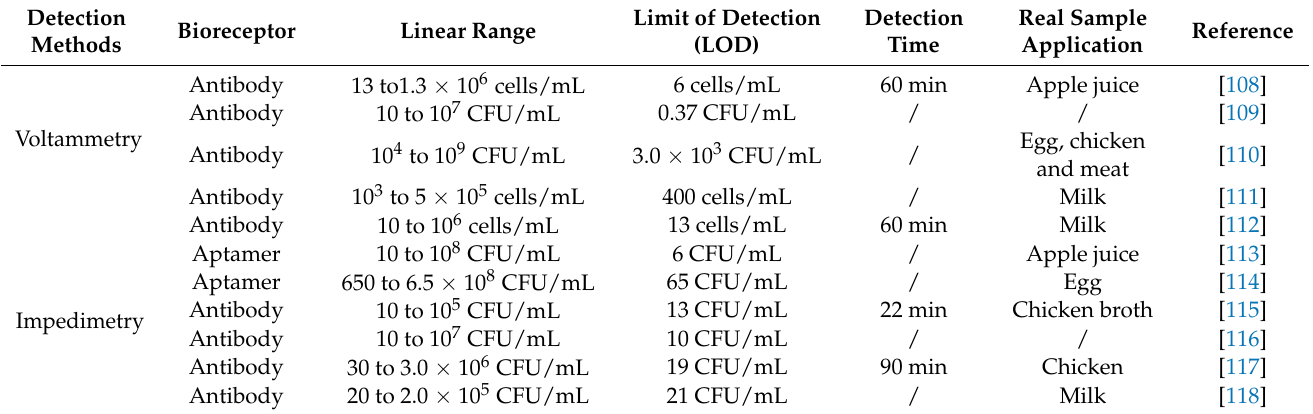
Table 3. Electrochemical sensors reported for Salmonella